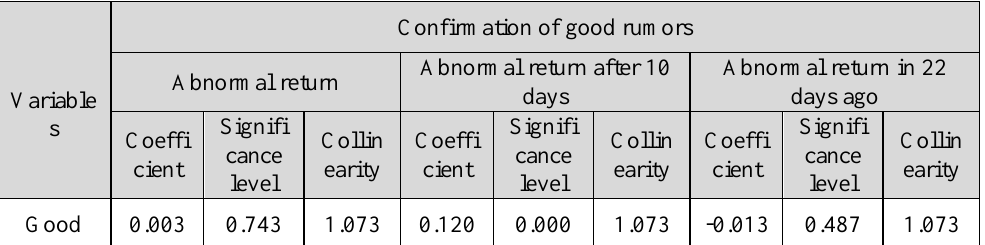
Table 8. Final estimation of the regressive model in second major hypothesis (Confirmation of good rumors and abnormal return, abnormal return at 10 subsequent days, abnormal return within 22 days